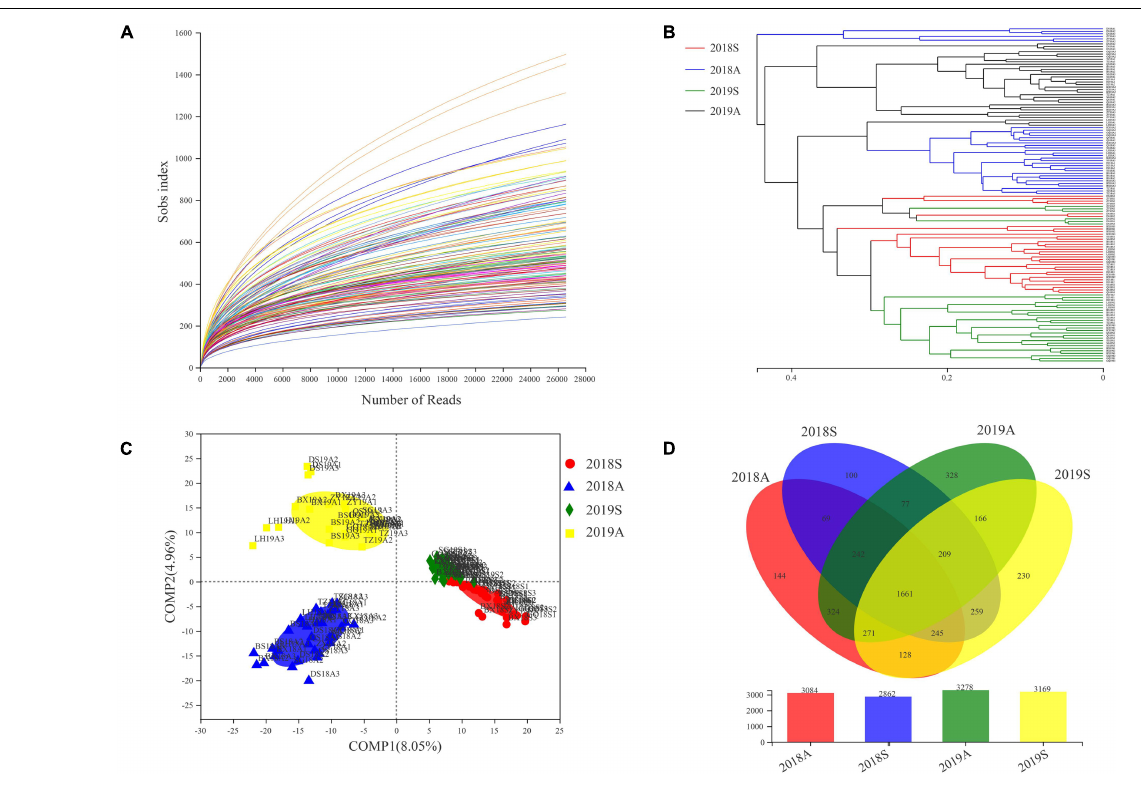
FIGURE 3 | Dilution curve (A) , UPGMA-tree (B) , PLS-DA (C) and Venn diagram (D) base on pyrosequencing of bacterioplankton